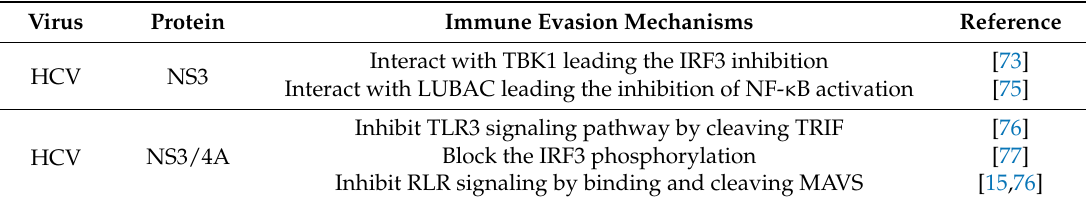
Table 2. Immune evasion by flaviviridae